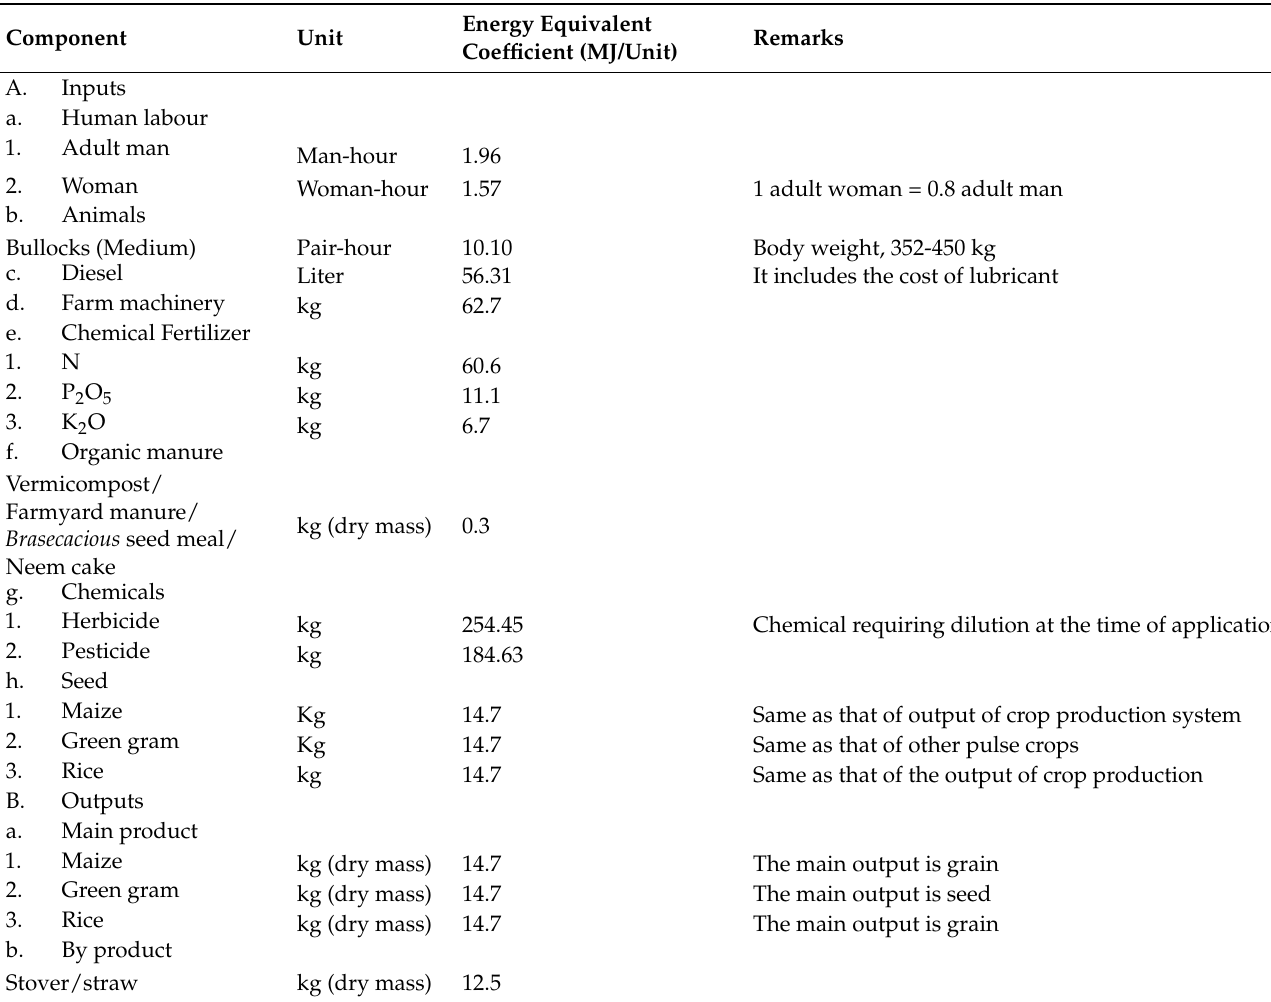
Table 2. Energy input and output of individual crop was calculated using an energy co-efficient for each treatment. Energy Equivalent Component Unit Coefficient